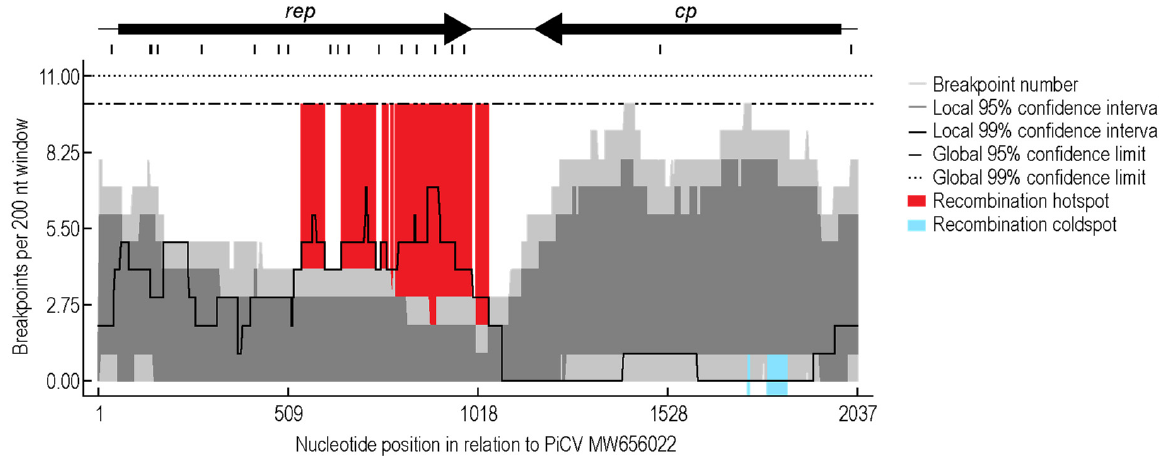
Figure 5. Recombination break point analysis for PiCV genomes from this study. Hot spots and cold spots are highlighted. Genome organization based on PiCV sequence MW656022 as a representative. Table 2. A summary of the recombination events detected in the genomes of PiCV from this study. The methods used to detect recombination are RDP (R), GENCONV (G), BOOTSCAN (B), MAXCHI (M), CHIMERA (C), SISCAN (S) and 3SEQ (T). For each recombination event, the method with the highest p -value is in bold font and underlined. [P] denotes partial evidence of recombination.